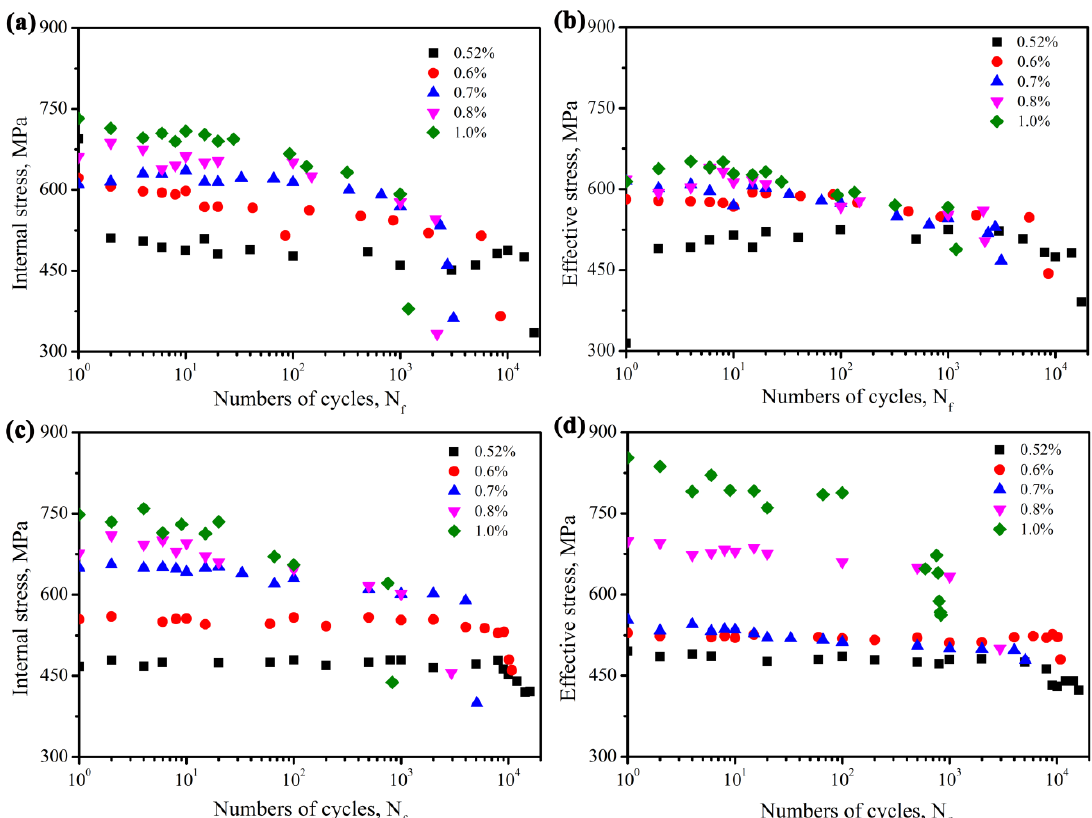
Figure 8. Evolution of the ( a ) internal stress and ( b ) effective stress with the number of cycles of 22MnSi2CrMoNi steel, ( c ) internal stress, and ( d ) effective stress versus the number of cycles of 00Ni18Co9Mo4Ti steel.